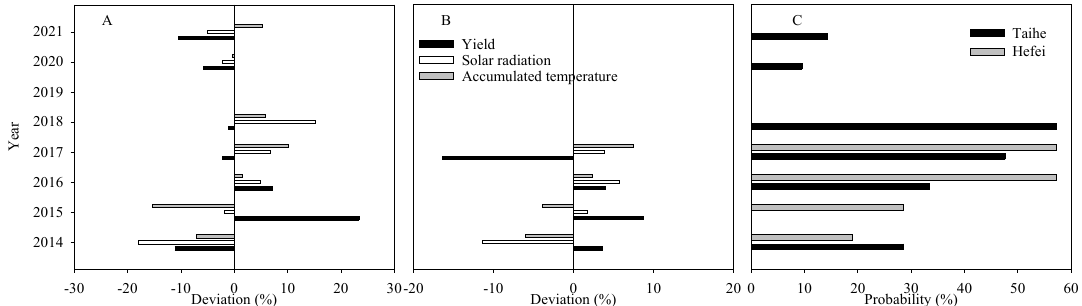
Figure 6. Deviation of grain yield, solar radiation, and accumulated temperature ≥ 10 ◦ C and the probability of a maximum temperature of ≥ 35 ◦ C during the 40 and 60 days after planting in Taihe and Hefei regions. Note: Figure ( A ) represents the deviation in Taihe, Figure ( B ) represents the deviation in Hefei, and Figure ( C ) represents the probability of a maximum temperature of ≥ 35 ◦ C. The average occurrence probability of T max ≥ 35 ◦ C in Hefei was 40.5% (Figure 6C), which was higher than the average value of 27.2% in Taihe. In Hefei, for example, in 2017, the occurrence probability of T max ≥ 35 ◦ C was 69.6% (Figure 6C). The T max ≥ 35 ◦